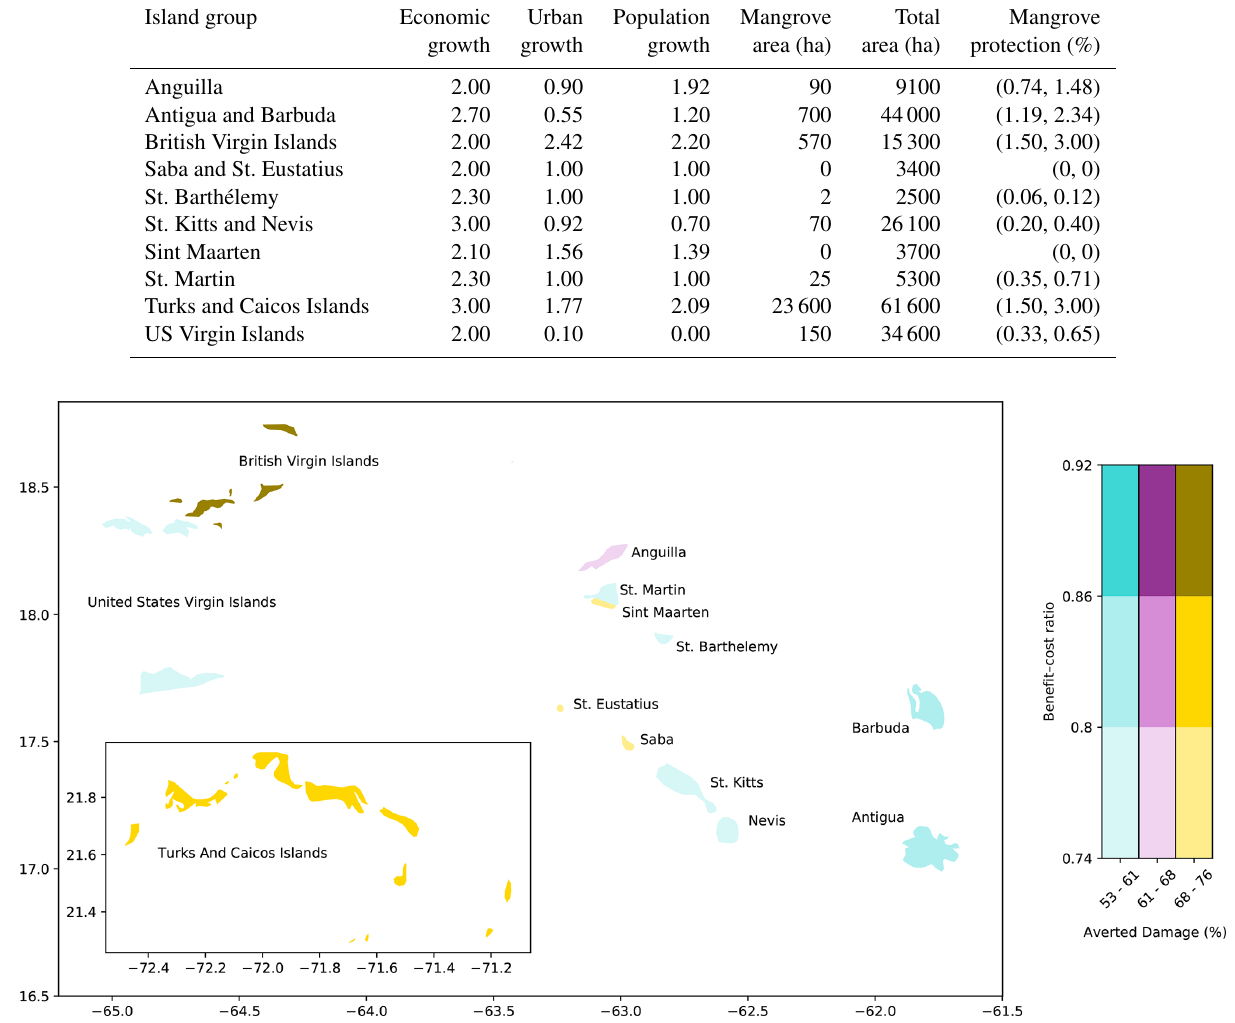
Figure 6. Cost–benefit relations in selected islands in the Antilles. The three most cost-effective measures are combined with the risk transfer solution, and the resulting net present value of the total expected averted damages from 2016 to 2050 (benefit) is categorized into three equally spaced ranges – cyan (53% to 61% of damages averted), purple (61% to 68%), and gold (68%–76%) – and the benefit–cost ratio is also shown in three indicative ranges. The color intensity represents the benefit–cost ratio: the darkest colors result in more cost-effective